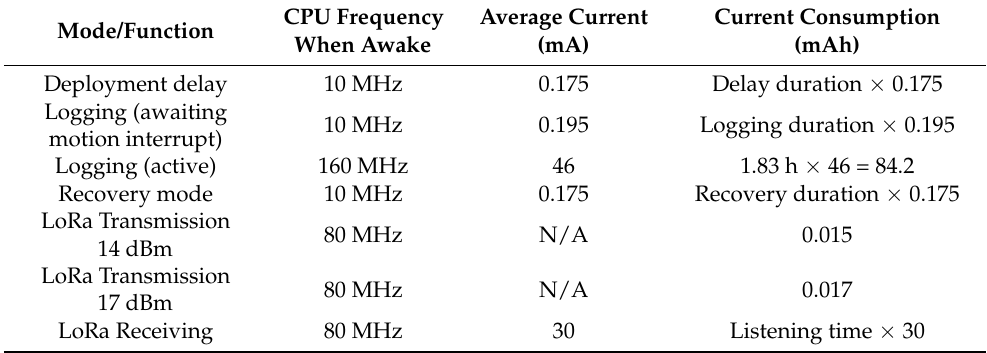
Table 1. Kinematic Logger modes and functions with CPU frequency, average current, and current consumption.